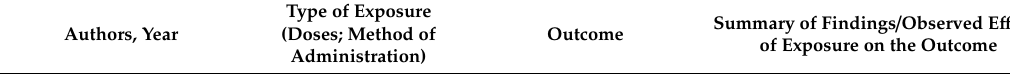
Table 1. Characteristics and main findings of the